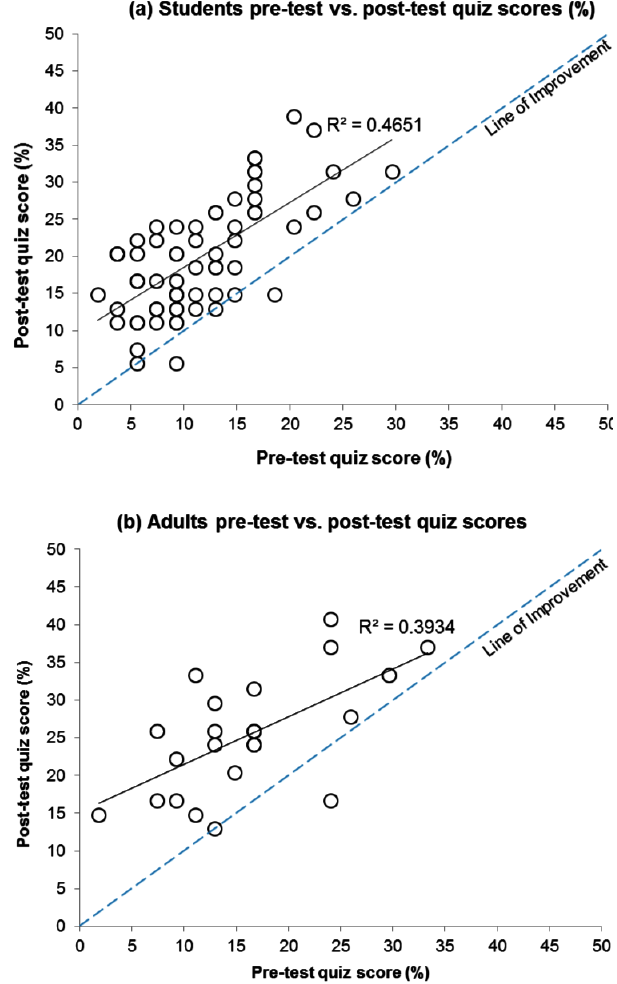
Figure 3. Graphs showing the preliminary pre-test and post-test knowledge quiz score marks in percentage for (a) Student partici- pants and (b) Adult participants. The dashed line represents the line of improvement between the two tests above which there is knowl- edge improvement.